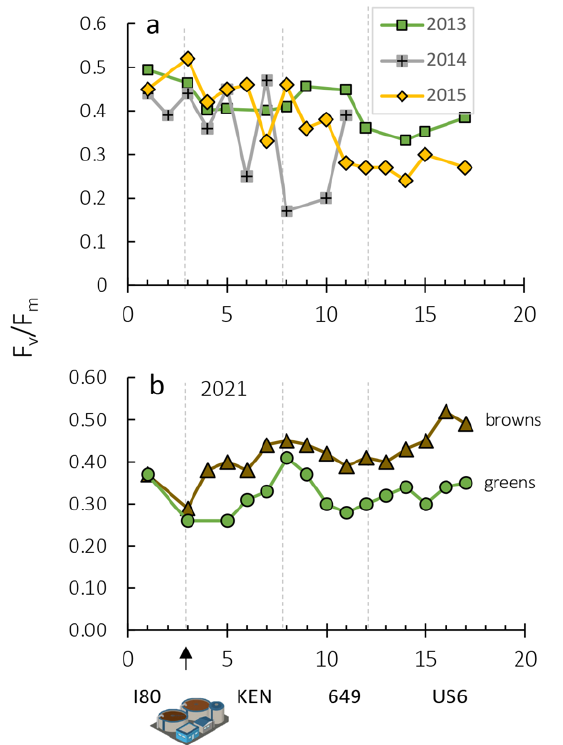
Figure 9. Transects of F v /F m for the years of sampling undertaken in the Bay Delta during Septem- ber/October prior to WWTP upgrade (panel a ) and for the brown and green algal groups for 2021 post WWTP upgrade (panel b ). Vertical dashed lines separate the major segments of the river/estuary. The WWTP icon shows location of discharge. Note the consistent downward trend for all years pre-upgrade and the upward trend for brown algae for 2021 post-upgrade.